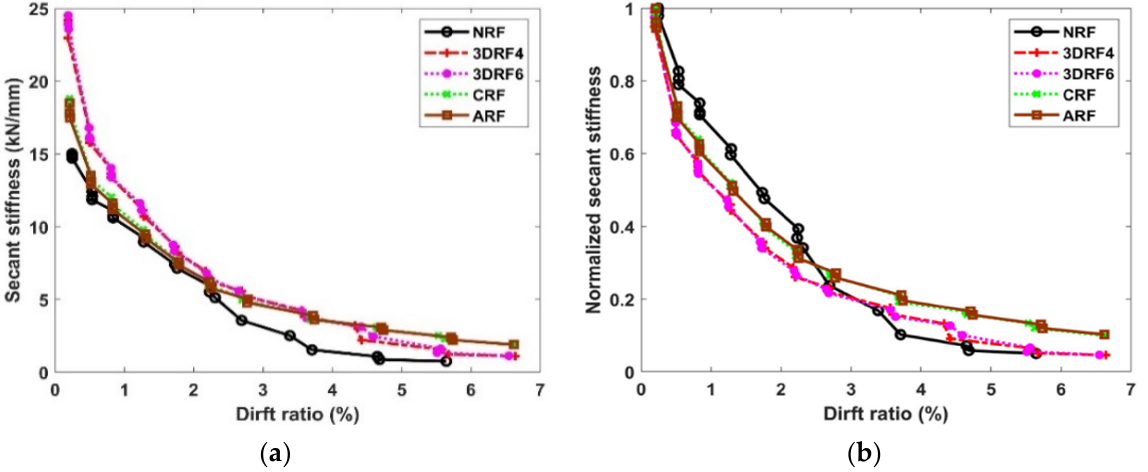
Figure 12. Secant stiffness and drift ratio: ( a ) Secant stiffness; ( b ) Normalized secant stiffness.